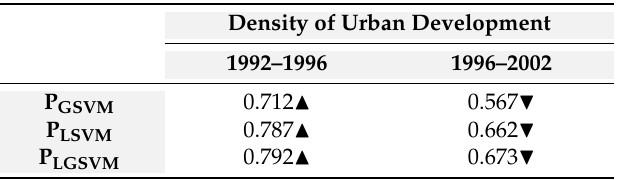
Table 6. Correlation between the density of urban development and the estimated probability in the periods of 1992–1996 and 1996–2002.